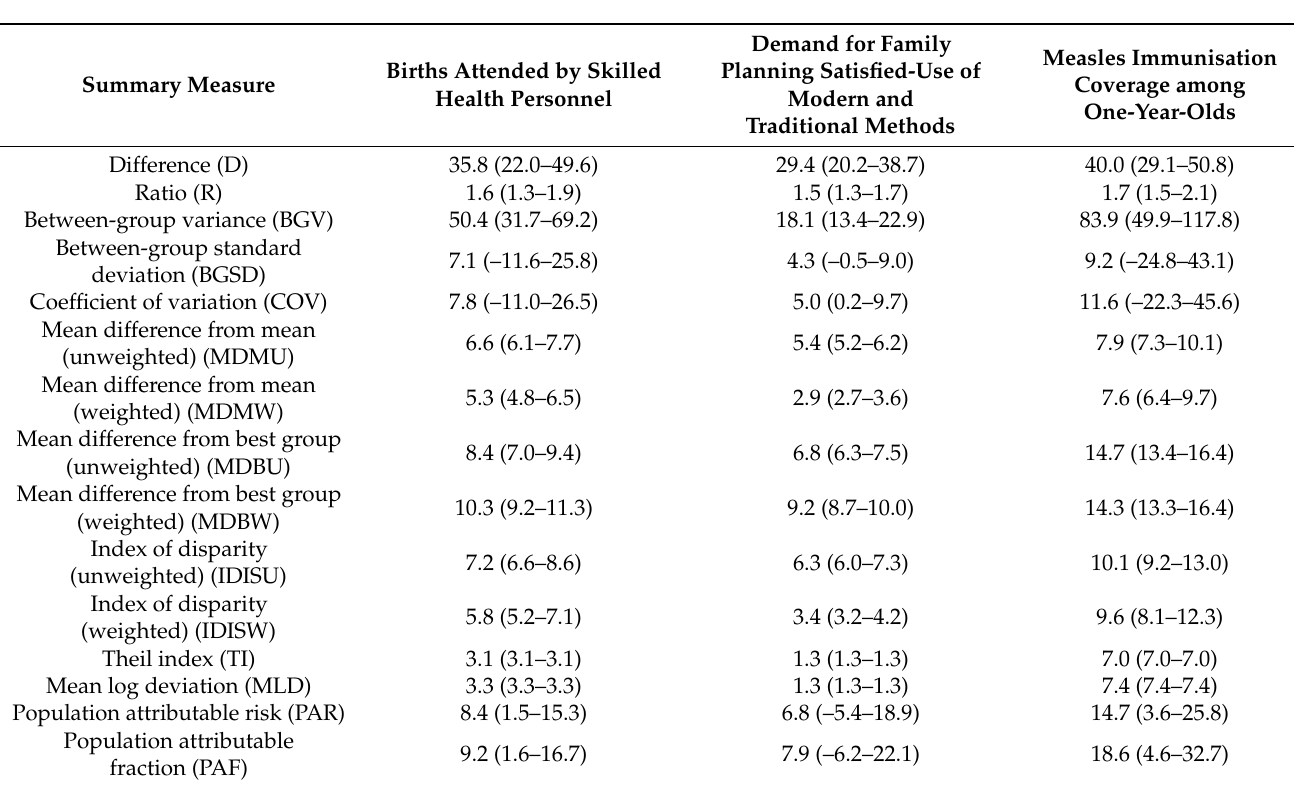
Table A9. Subnational regional inequality in three reproductive, maternal and child health indicators: Indonesia (DHS